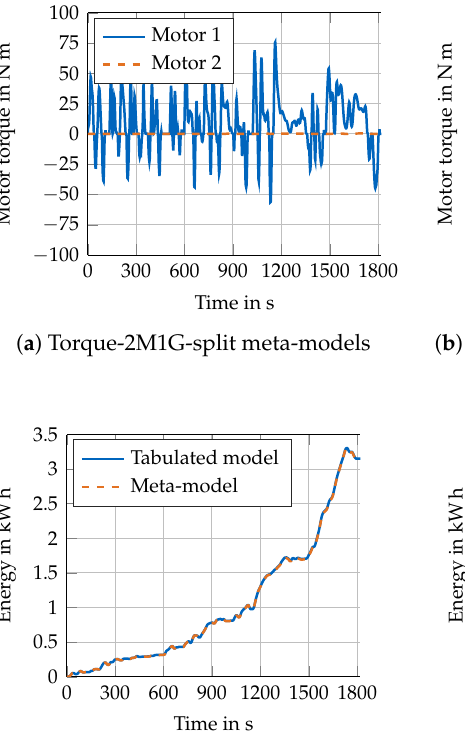
( c ) Torque-2M1G-continuous low-order meta-models